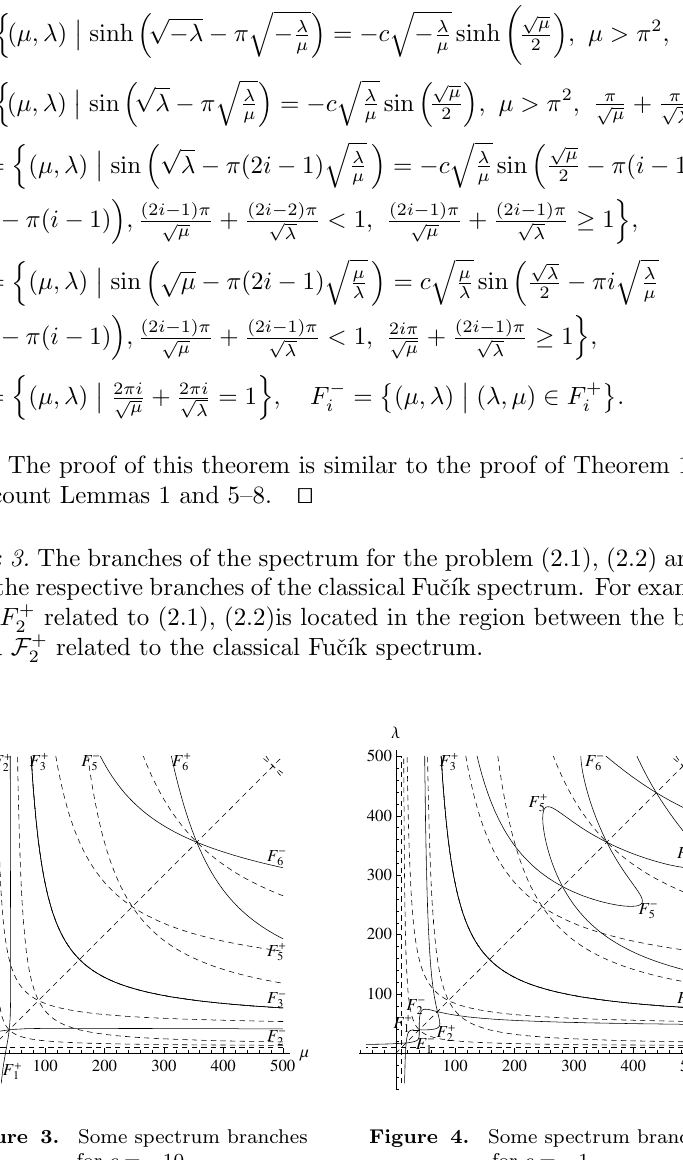
Figure 3. Some spectrum branches for c = − 10.